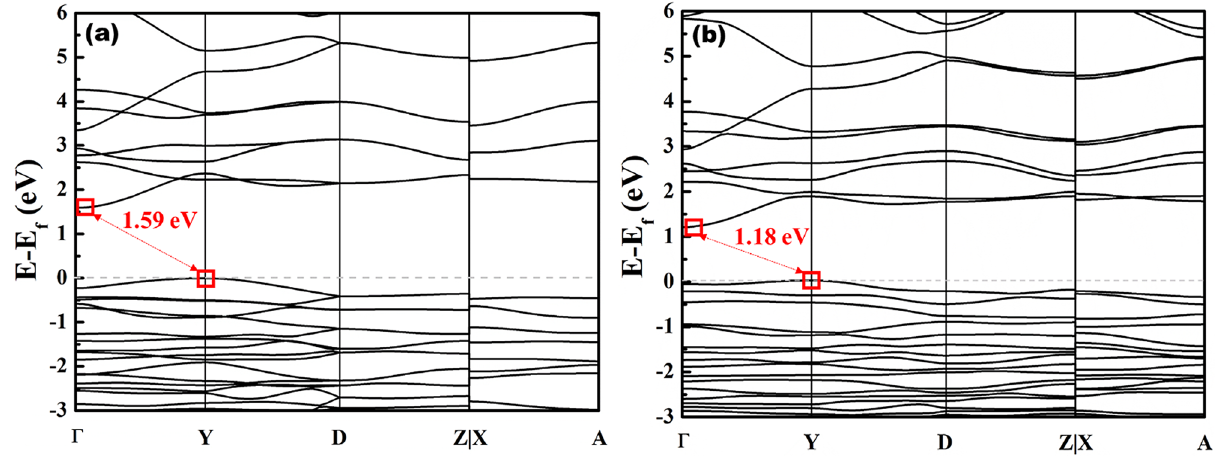
Figure 5. Electronic band structures of ( a ) KBFO and ( b ) N-KBFO calculated using DFT